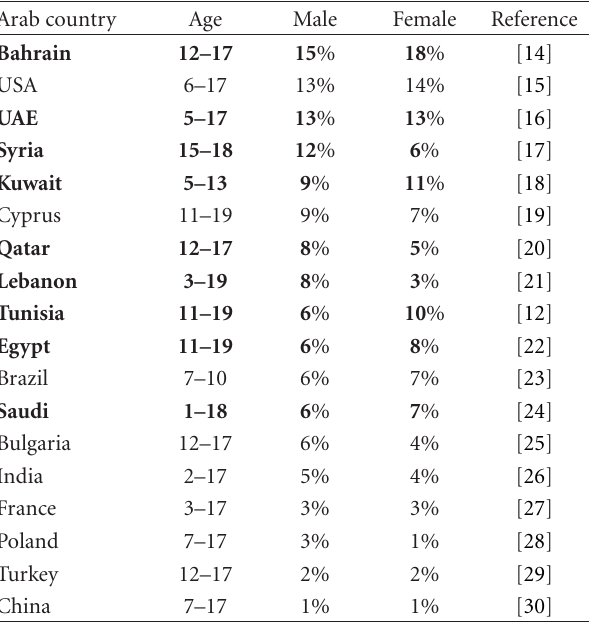
Table 2: Prevalence of obesity (Arabic speaking in bold) in both males and females in a various countries. Data are for children and adults aged between 2 and